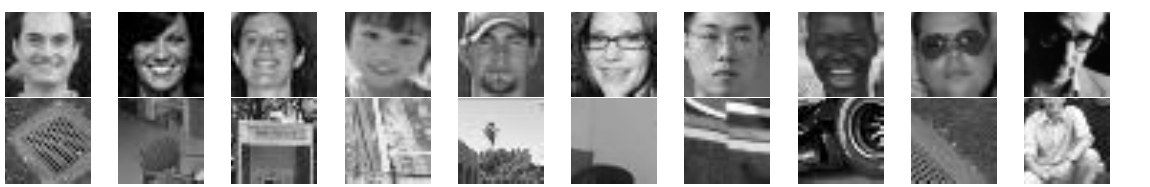
Figure 1. Training data used in face detection problem. First row: face images. Second row: non-face